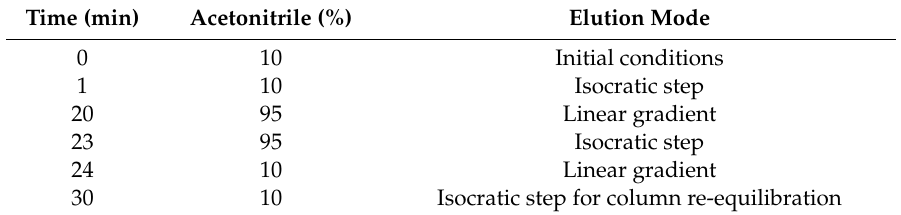
Table 1. Chromatographic elution program for the generation of liquid chromatography-high-resolution mass spectrometry (LC-HRMS) fingerprints.